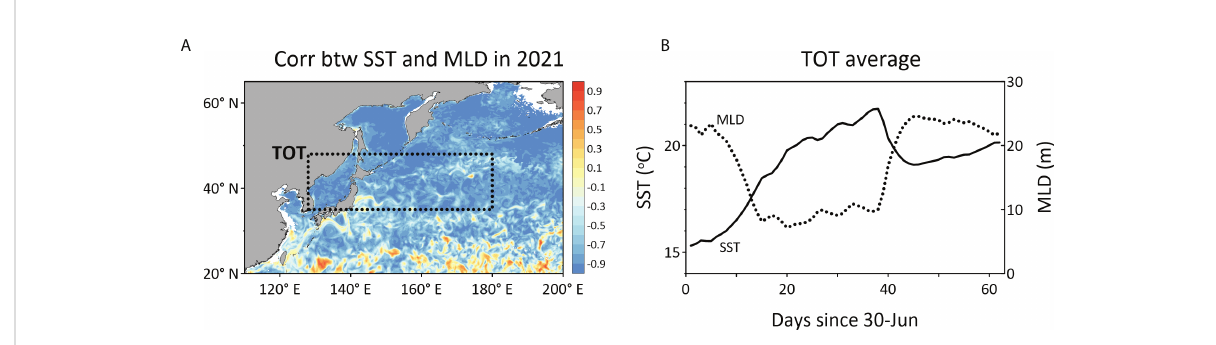
FIGURE 4 (A) Spatial map showing the distribution of correlation between the daily sea surface temperature (SST) and mixed-layer depth (MLD) during July – August 2021. (B) Time series plot of SST and MLD in the total (TOT) mid-latitude in the western North Paci fi c